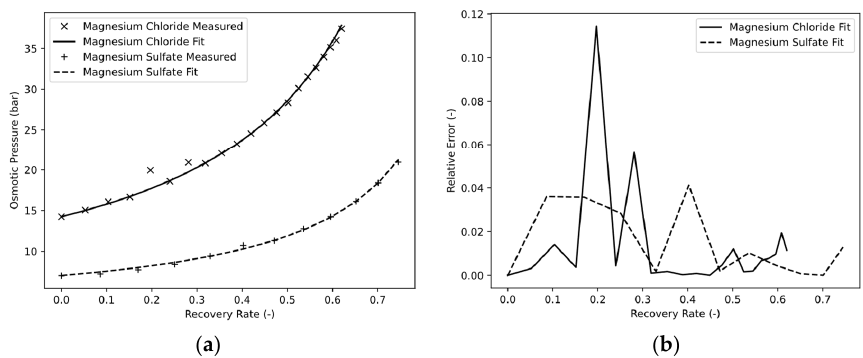
Figure 5. Osmotic pressure ( a ) and relative error ( b ) as a function of the recovery rate. Figure 5b shows the relative error of the fit function to the measured values. For mag ‐ nesium chloride, two flawed measured points can be seen at approximately RR = 0.2 and RR = 0.29, which were probably due to sampling errors. If excluded, the fit functions for both solutions showed a relative error of less than 5% for the entire concentration process.